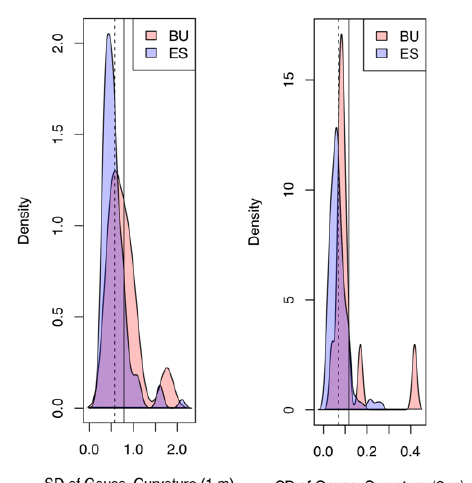
Figure A1: Histogramms of SD for 6.25 m 2 tree crown sub regions of gaussian curvature for 1 m and 2 m neighbourhood radius (beech and ash